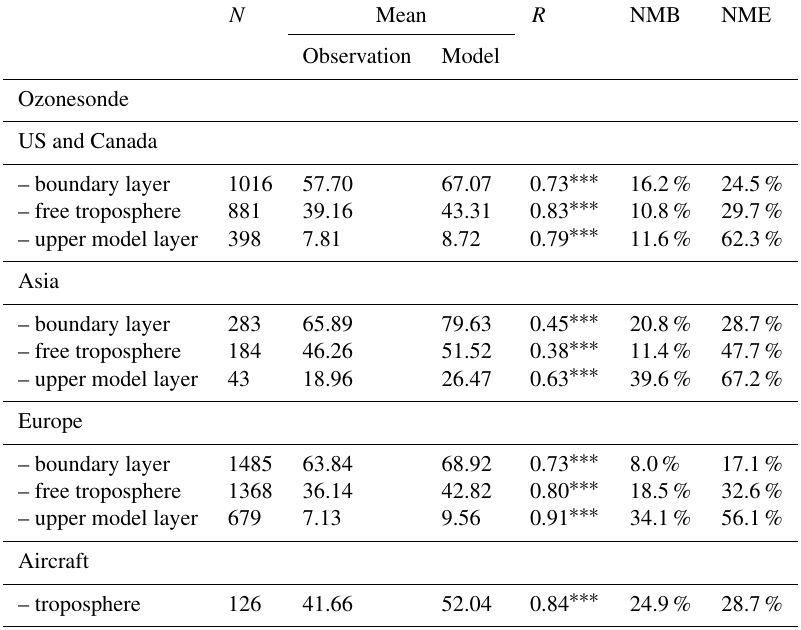
Table 4. Statistical analysis of modeled RH using ozonesonde and aircraft observations. N Mean R NMB NME Observation Model Ozonesonde US and